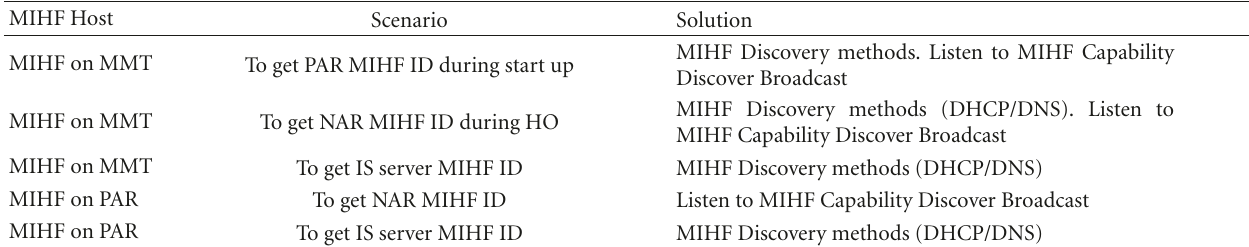
Table 1: Methods for getting MIHF